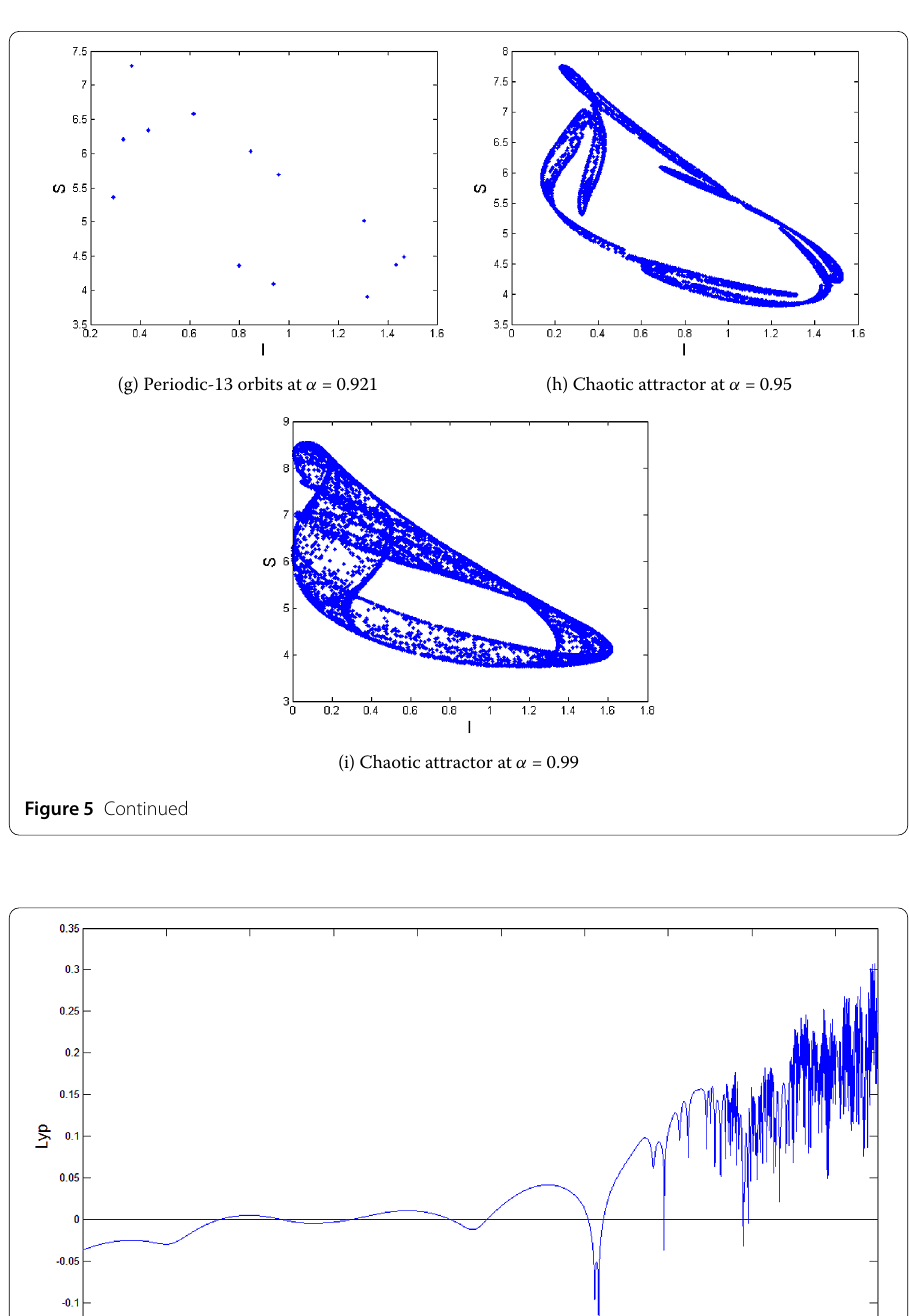
computed in Figure 3 corresponding to observations in Figure 1(a)–(c). It is observed that some LE values are positive and some are negative, so there exist stable fixed points or stable period windows in the chaotic regions. Generally, a positive LE is considered to be one of the characteristics which imply the existence of chaos ( e.g. when h >